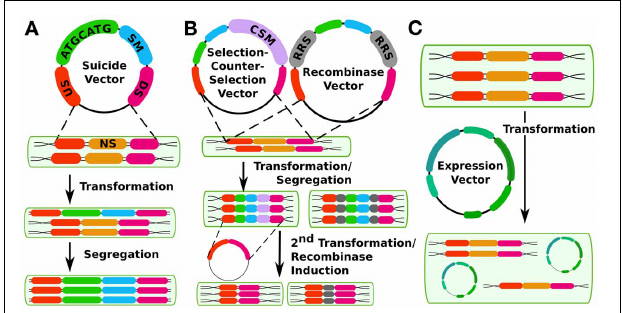
FIGURE 1 | Different methods for constructing cyanobacterial mutants. (A) shows the traditional method using double homologousrecombination to insert a suicide vector into the genome at a neutral site (NS, gold) with upstream (US, orange) and downstream (DS, magenta) flanking regions in the vector. The insert contains an arbitrary sequence of interest (ATGCATG, green) and a selectable marker (SM, blue). (B) shows two methods of creating markerless mutants, either by selection-counterselection or by using a recombinase system such as FLP/FRT, The counter-selection method’s first step is the same as for the method in panel a, except that the insert also contains a counter-selectable marker (CSM, purple) such as sacB . A second transformation is performed to create a markerless mutant. Alternatively, the insert can contain recombinase recognition sites (RRS, gray) that are controlled by an inducible recombinase at a second (or the same) site in the genome. While it erases the selectable marker, this method does leave a scar sequence behind. (C) shows genetic modification in trans via expression plasmids.